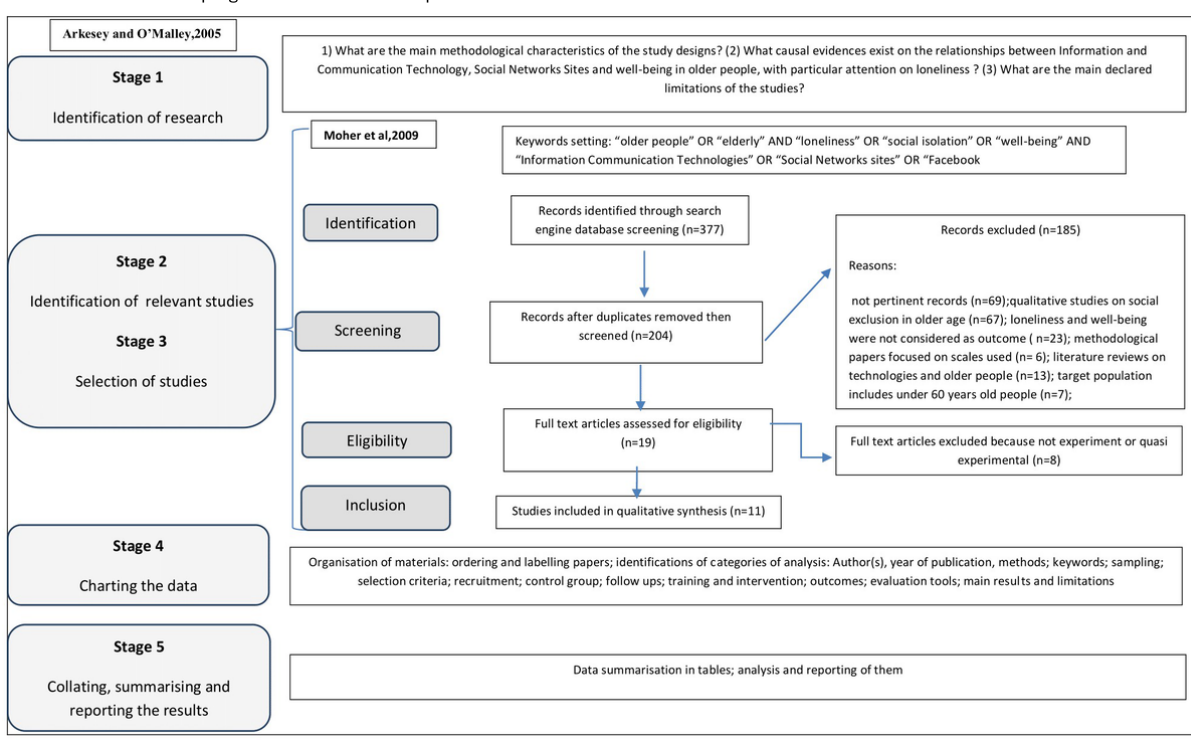
Figure 1. Flowchart of scoping review: methods and